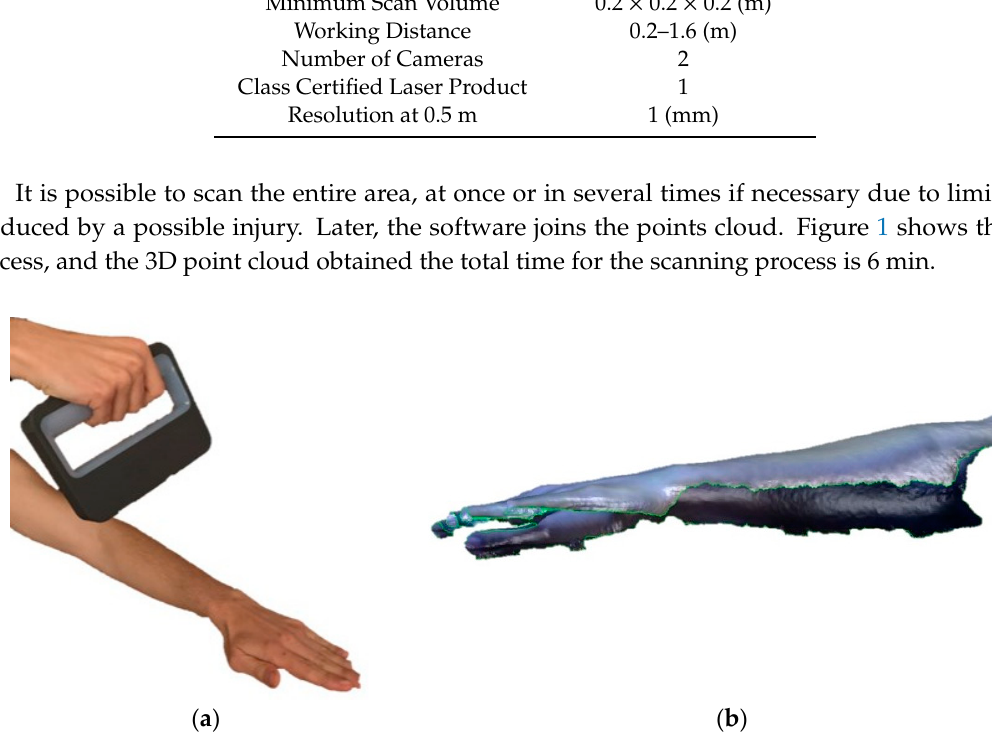
Figure 1. Scanning process of the arm to get the digital model ( a ) and points cloud ( b ).